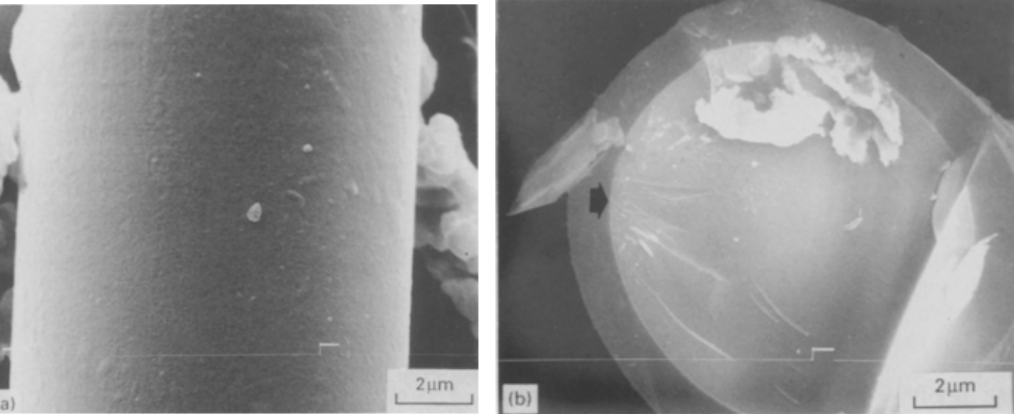
Figure 39. SEM micrographs of the surface ( a ) and fracture surface ( b ) of the S fibers oxidized for 300 h in air at 800 °C. The arrow shows the fracture origin. Reprinted with permission from Reference [131]. Copyright 1994 Springer Nature.